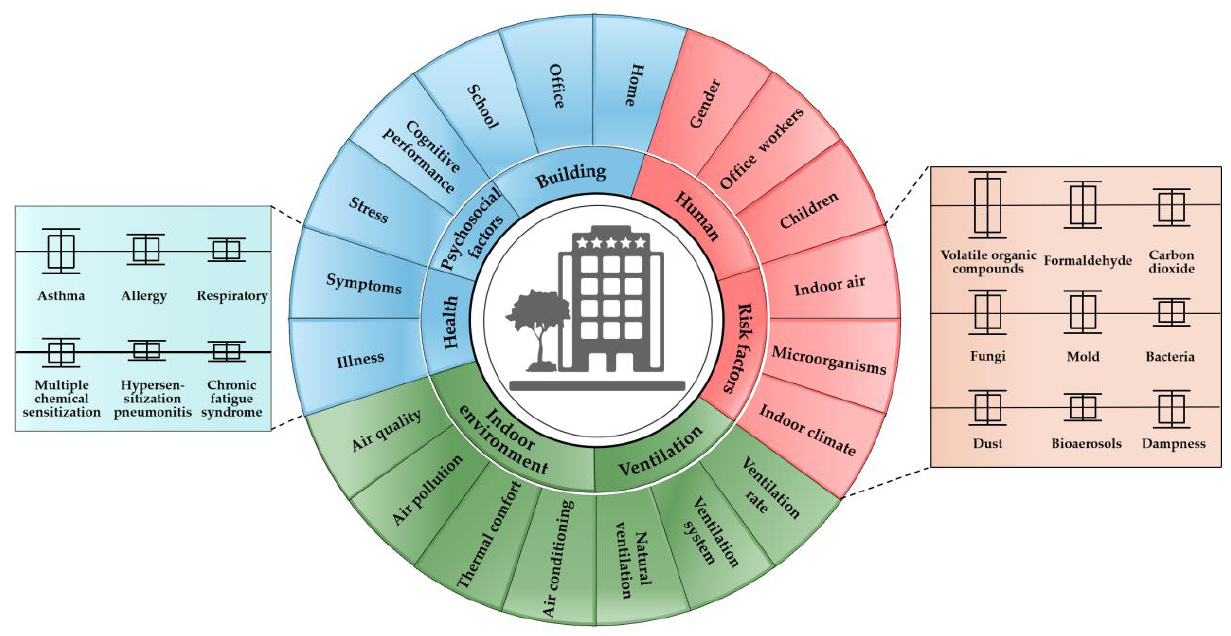
Figure 5. Keywords statistic and cluster of the SBS.